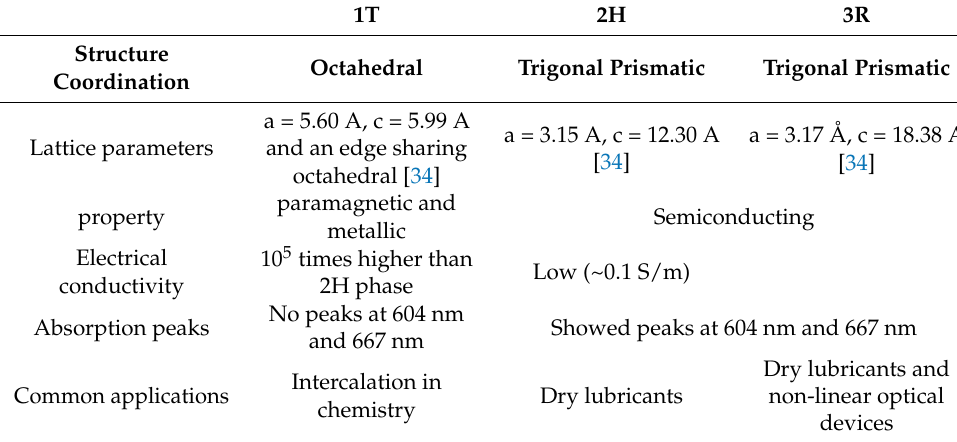
Figure 1. Different coordination and stacking sequences of the three MoS 2 structures 1T, 2H and 3R. Reproduced from [33]. Published by The Royal Society of Chemistry. Table 1. Comparison between different MoS 2